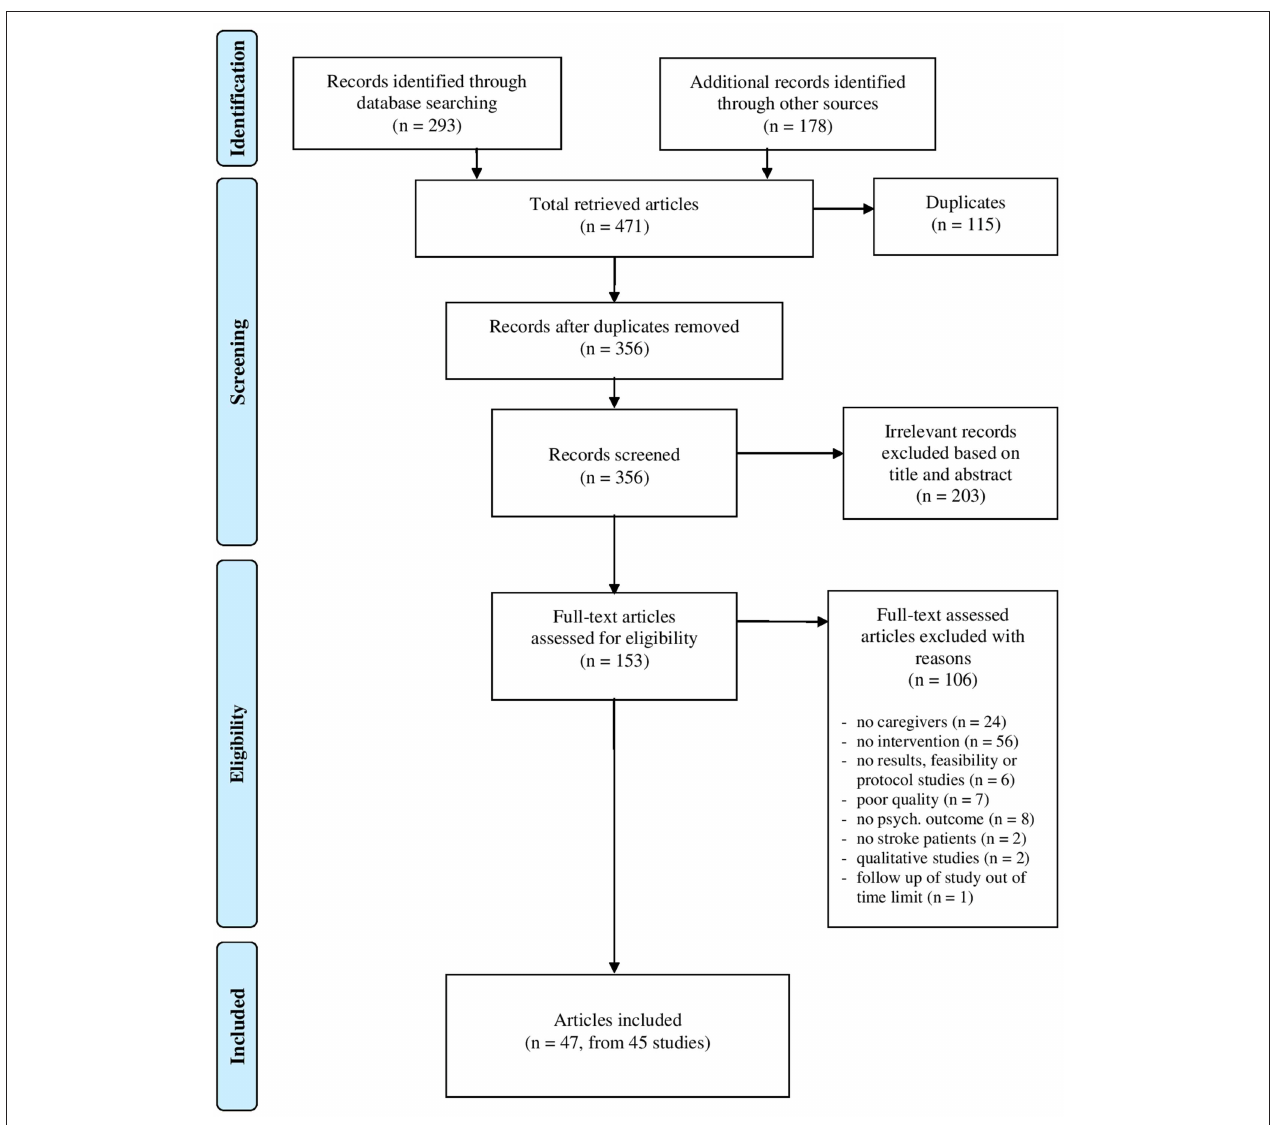
FIGURE 1 | PRISMA Flow Diagram: study retrieval and